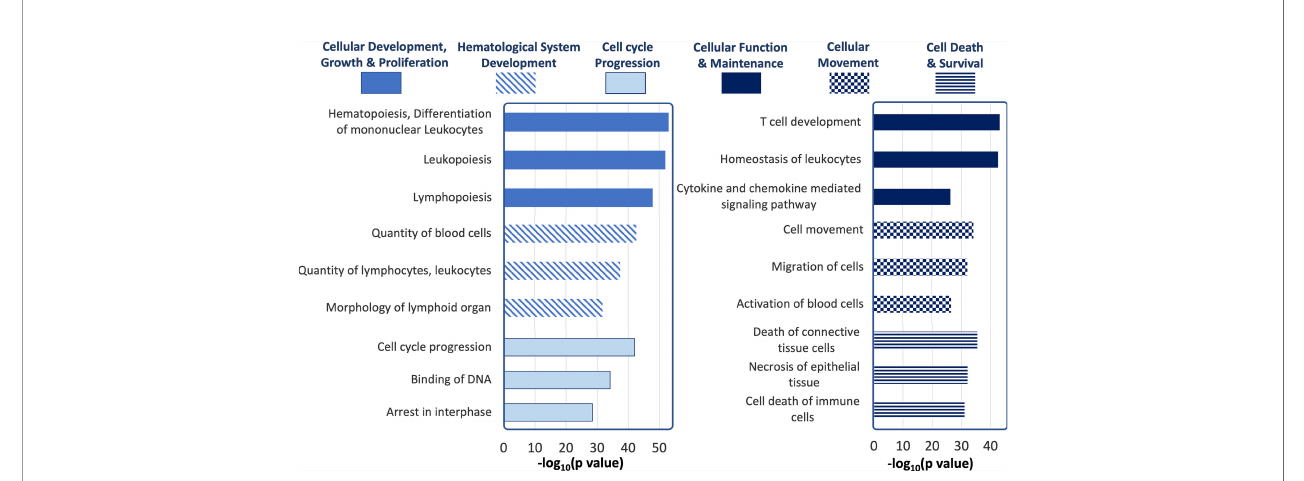
FIGURE 8 | Ingenuity Pathway Analysis of tear miRNA hits. The most statistically signi fi cant biological functions and processes generated by IPA for the genes targeted by the differentially expressed tear miRNA hits, grouped by function categories (p values calculated by IPA based on Table 1